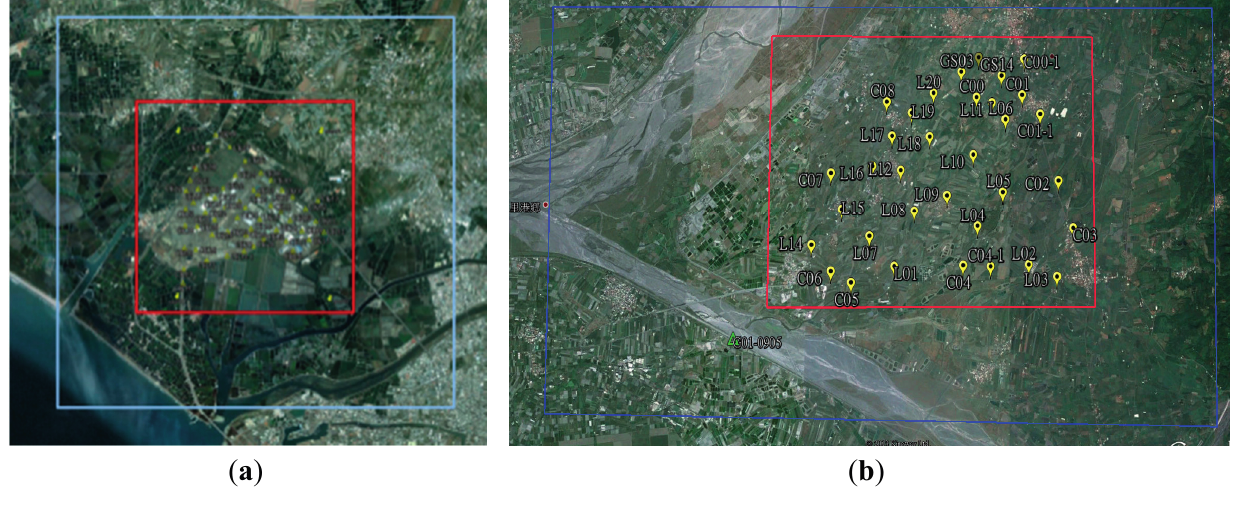
Figure 18. The scopes of the two